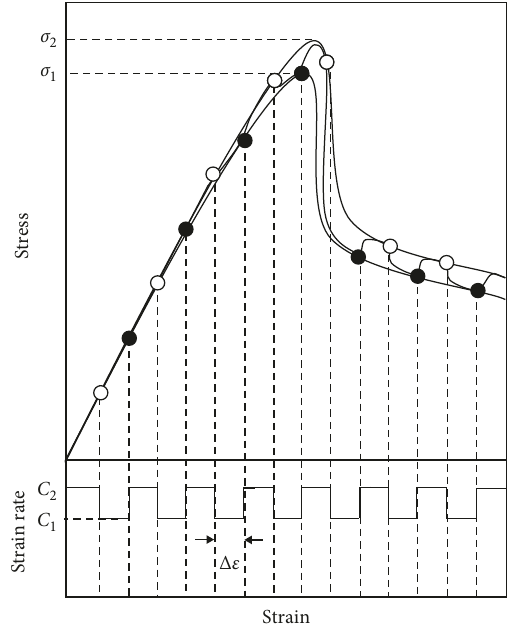
Figure 2: Schematic graph of alternative loading rate test